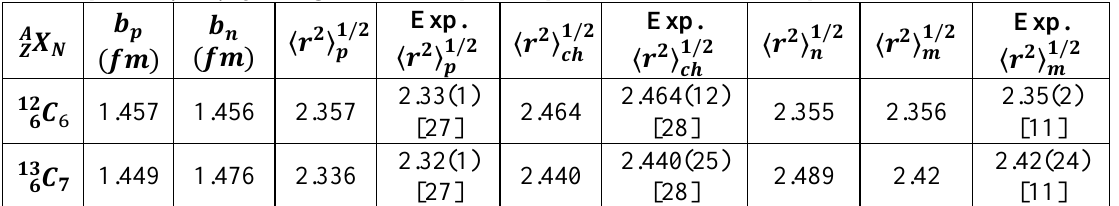
Table 8: Calculated proton, charge, neutron, matter radii in Fermi’s for stable carbon isotopes 12 C, 13 C, by using HO technique compared with available experimental